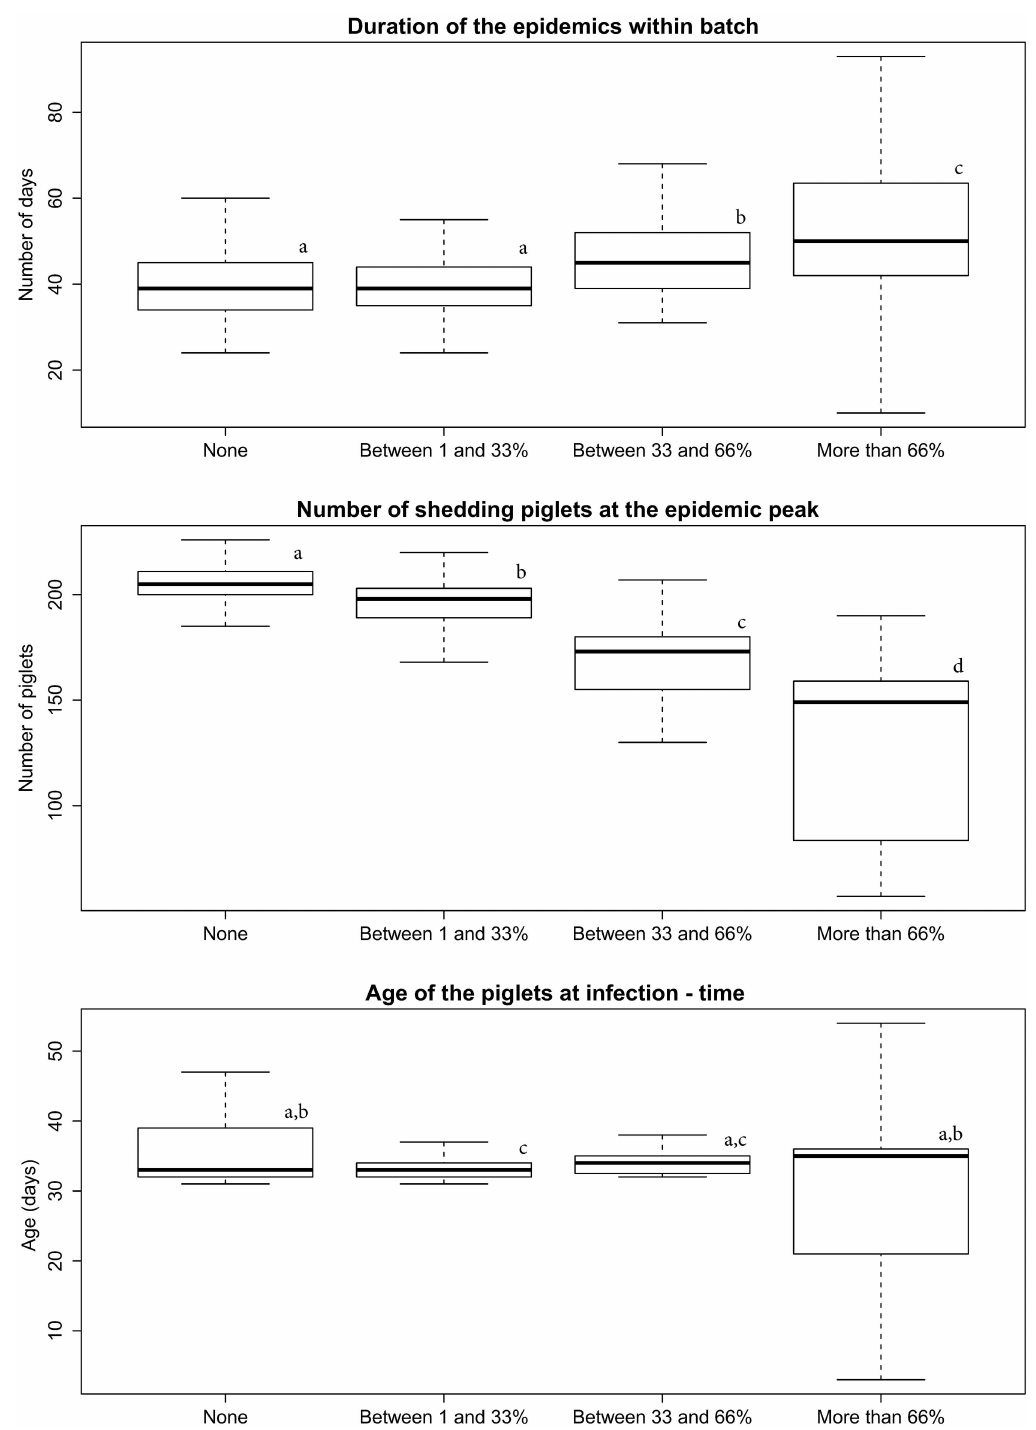
Fig 5. Characteristics of the epidemics within batches according to the prevalence of MDA-positive piglets. A. Duration of the epidemicswithin batch. B. Number of sheddingpiglets at the epidemicpeak. C. Age of the piglets at